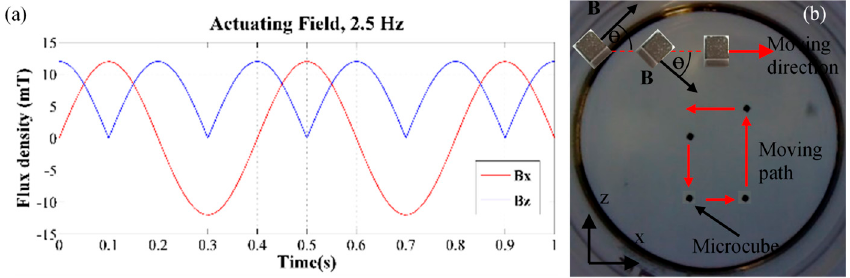
Figure 10. Sweeping-slip locomotion by oscillating field. ( a ) oscillating signal produces the superposition of the x- and z-magnetic field, B x and B z , sampled by 2.5 Hz. ( b ) the motion path of the microcube which sweeps from the left to right side rapidly to slip forward.